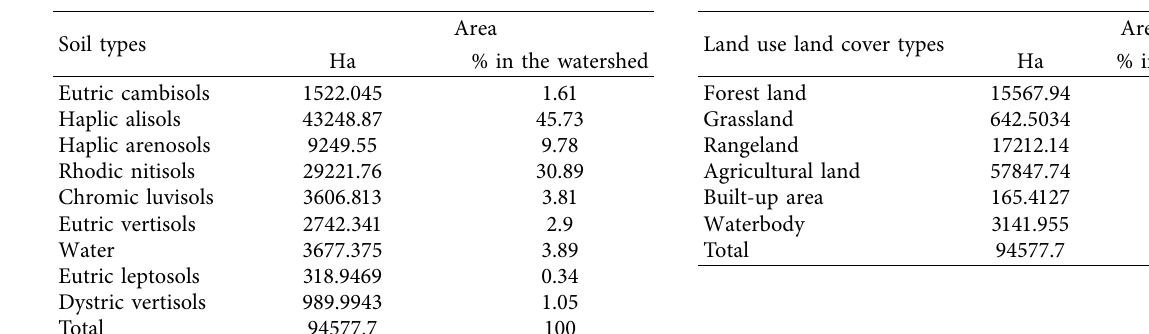
Table 2: Soil types of the study area with their aerial coverage. Table 3: Land use types of the study area with their aerial coverage.